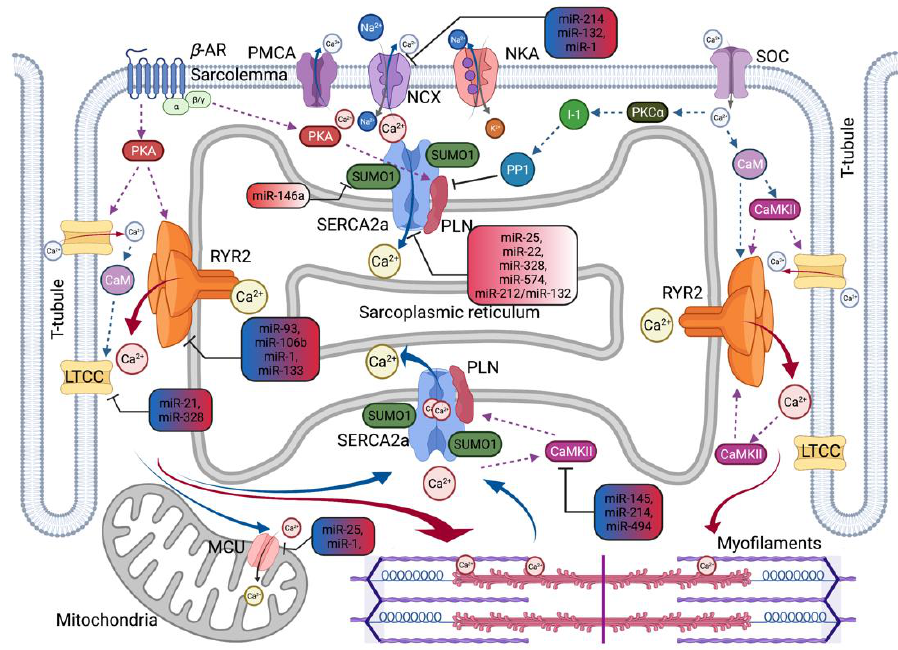
Figure 2. MicroRNA-Regulated Changes in Calcium Cycling in Heart Diseases. Schematic overview summarizes miR-mediated regulation of key Ca 2+ handling proteins in heart diseases. CaMKII, Ca 2+ /CaM-dependent kinase II; LTCC, L-type Ca 2+ channel; MCU, Mitochondrial Ca 2+ uniporter; NCX, Na + /Ca 2+ exchanger; RYR2, Ryanodine receptor type-2; SERCA2a, Sarcoplasmic reticulum Ca 2+ -adenosine triphosphatase 2; and SUMO1, Small ubiquitin-like modifier type 1. Red solid arrow represents Ca 2+ -induced Ca 2+ release. Blue solid arrow represents Ca 2+ extrusion in diastolic relaxation. Dotted lines represent a positive or negative effect on the following molecules. Upregulated miRNAs represent in a red gradient-filled rounded rectangle. The varying expression changed miRNAs in heart disease represent in both blue and red gradient-filled rounded rectangles.